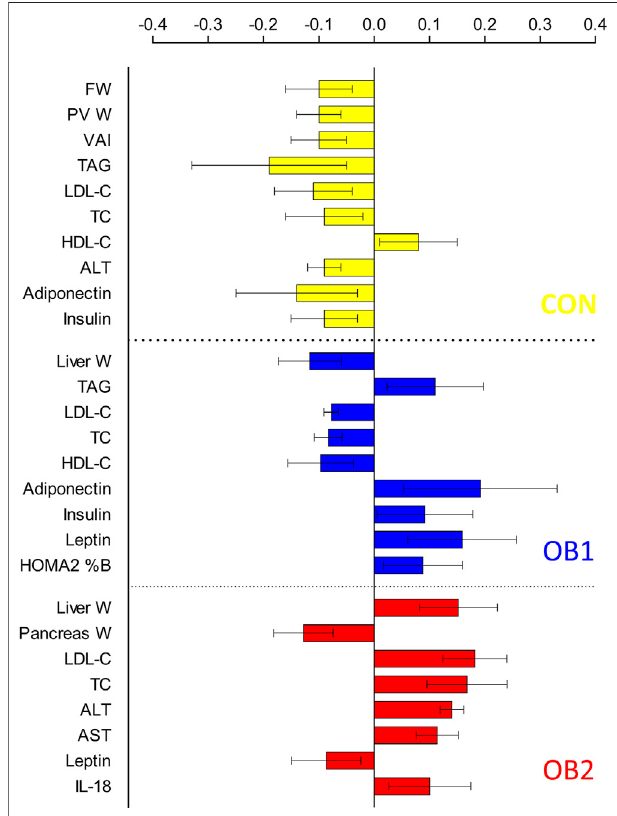
FIGURE 4 | Multivariate association of metabolic variables with dietary group: partial correlation coef fi